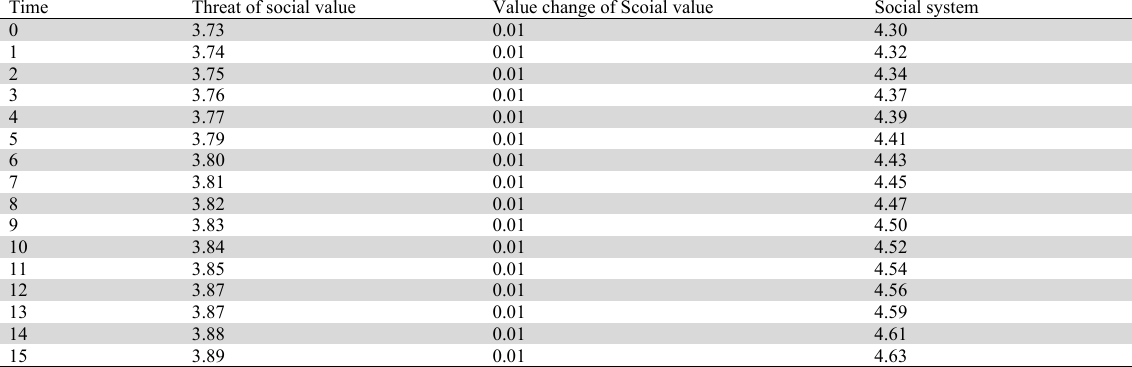
Influence on Islamic State Development on Social